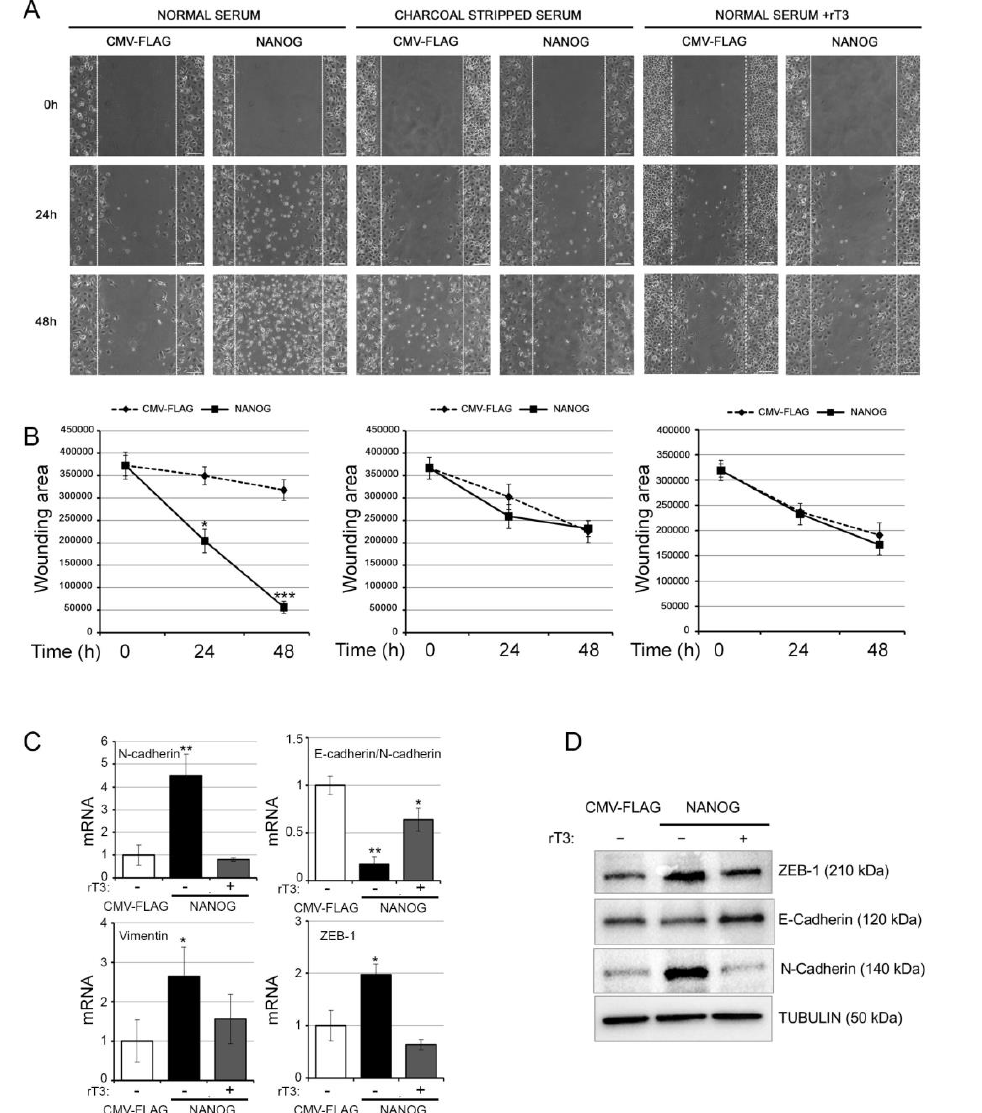
Figure 5. D2 inhibition attenuates the migration and mesenchymal gene expression of BCC cells induced by NANOG. ( A ) A Wound scratch assay was performed with BCC cells transfected with THE NANOG plasmid or the CMV-FLAG plasmid. The migration index was measured at 0, 24, and 48 h, under three culture conditions: (i) normal serum, (ii) charcoal-stripped serum, and (iii) normal serum + 30.0 nM rT3. Scale bars represent 100 µ m. ( B ) Summary graph showing wounding area at the indicated time points during the scratch wound assay as in A. Data represent the mean of three independent experiments performed in duplicate. ( C ) N-cadherin, E-cadherin / N-cadherin ratio, vimentin, and ZEB-1 mRNA levels in BCC cells transfected with the NANOG plasmid or the CMV-FLAG plasmid and treated or not with 30.0 nM rT3. ( D ) Western Blot analysis of E-cadherin, N-cadherin, and ZEB-1 expression in the same cells as in C. Tubulin expression was measured as a loading control. Data represent the mean of three independent experiments. * p < 0.05; ** p < 0.01.